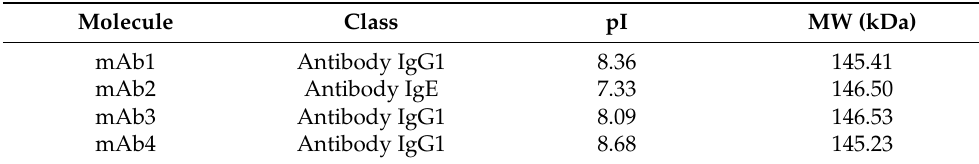
Table 2. Monoclonal antibodies and their